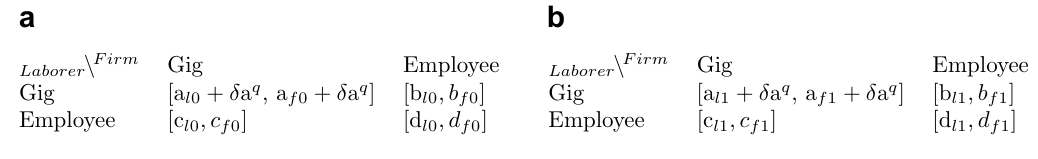
Figure 4: Strict Policy, Matrix Operation